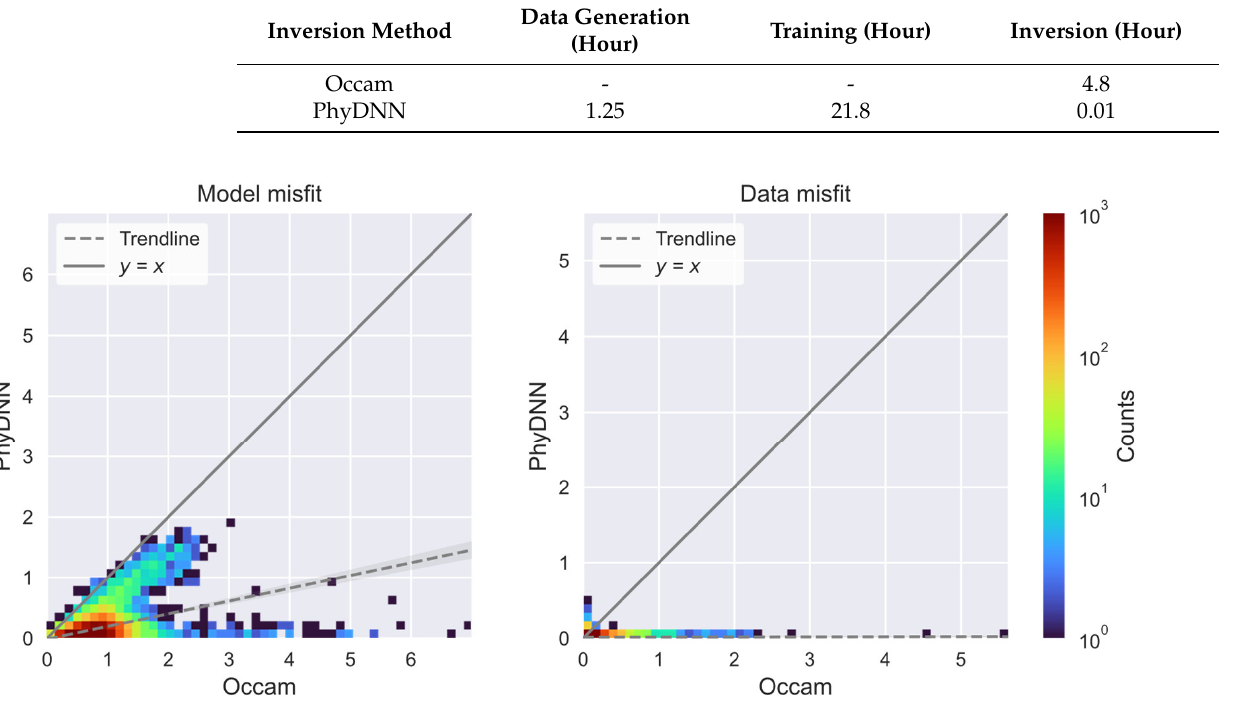
Table 4. Computational loads of the Occam and PhyDNN for inverting the test set. Inversion Method Data Generation (Hour)